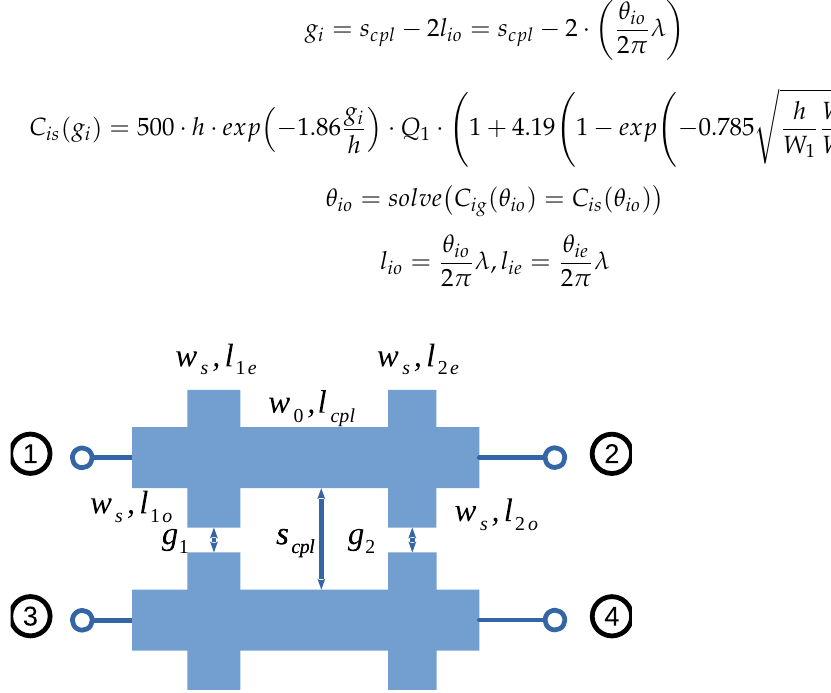
Figure 5. Physical realization of the